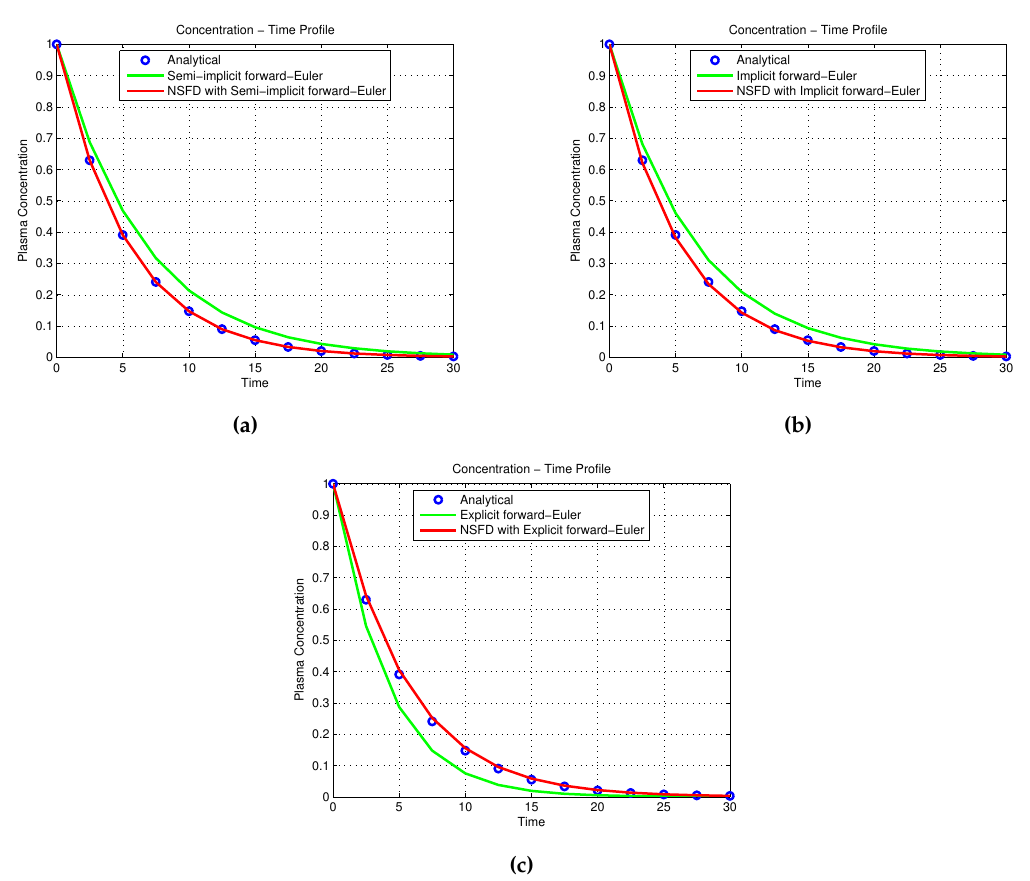
Figure 7. ( a ) NSFD scheme (31) in case 1 plotted against the analytical solution (19) and the corresponding SFD scheme (25); ( b ) NSFD scheme (33) in case 2 plotted against the analytical solution (19) and the corresponding SFD scheme (32) and ( c ) NSFD scheme (36) in case 3 plotted against the analytical solution (19) and the corresponding SFD scheme